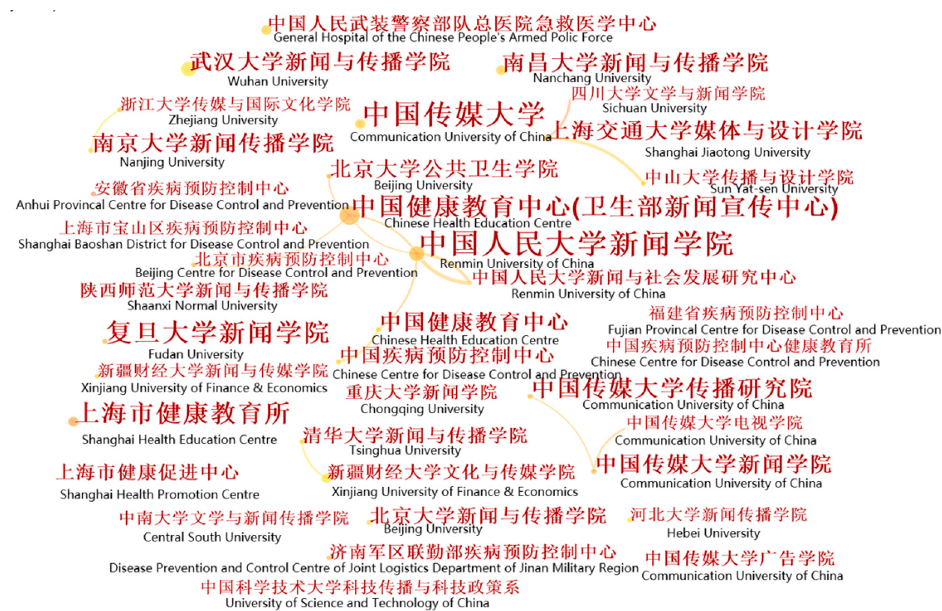
Figure 4. Institutional collaboration network map for the field of HC in China. (Note: the authors added English to the map to aid understanding).